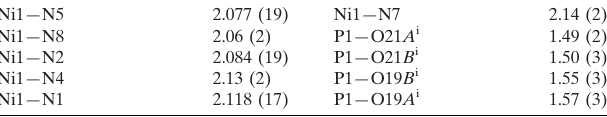
In the one-electron